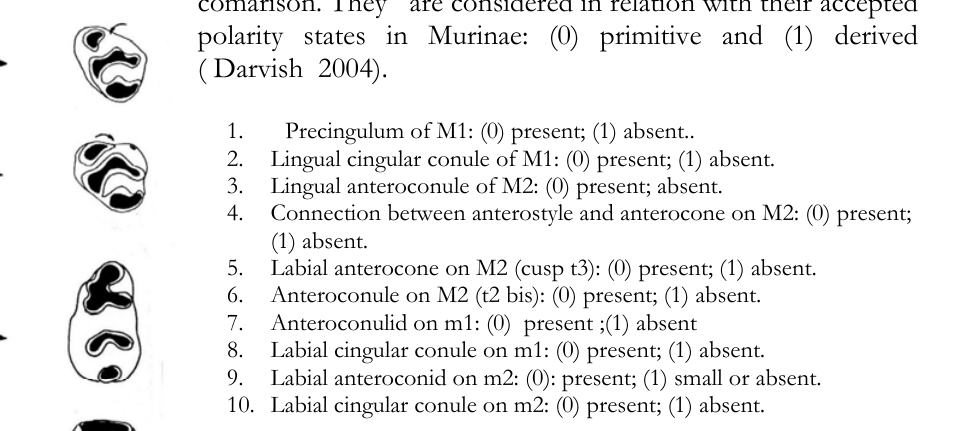
F IG .3.- List of complementary characters used for